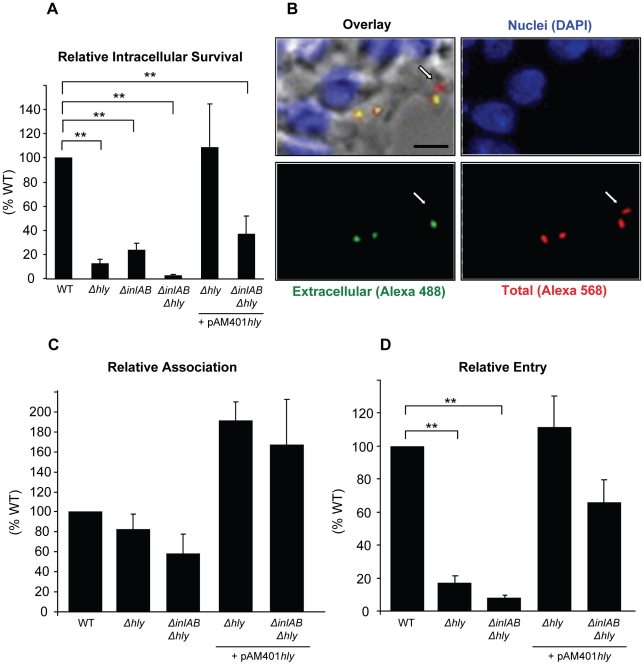
LLO is required for efficient entry of L. monocytogenes into HepG2 cells.(A) HepG2 cells were infected with isogenic WT (DP10403S), LLO-deficient (Δhly), InlAB-deficient (ΔinlAB), LLO- and InlAB-deficient (ΔhlyΔinlAB), or LLO-complemented (Δhly + pAM401hly; ΔhlyΔinlAB +pAM401hly) bacteria (MOI = 20) for 30 min at 37°C. Gentamicin was added for 1 h and the CFUs were enumerated as described in methods. Results were the mean ± SEM (n≥3) and expressed relative to WT. Statistics indicated here and elsewhere are as follows: * p<0.05; ** p<0.005. (B) to (D) Cells were infected with WT, LLO-deficient (Δhly), LLO- and InlAB-deficient (ΔhlyΔinlAB), or LLO-complemented (Δhly + pAM401hly; ΔhlyΔinlAB + pAM401hly) bacteria (MOI = 20) for 30 min at 37°C. Cells were washed, fixed, and labeled with fluorescent antibodies and DAPI. (B) Representative images of WT extracellular bacteria (green), total bacteria (red), and HepG2 nuclei (blue). The arrow indicates an internalized bacterium. Scale bar = 10 µm. In (C) and (D), results were the mean ± SEM (n≥3) and were expressed relative to WT.